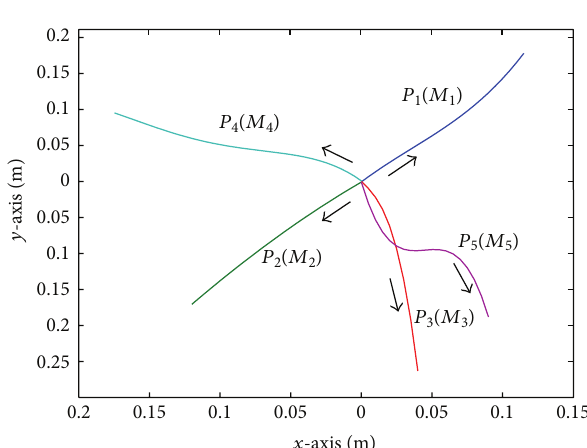
Figure 10: One example of motion path (Algorithm 1).